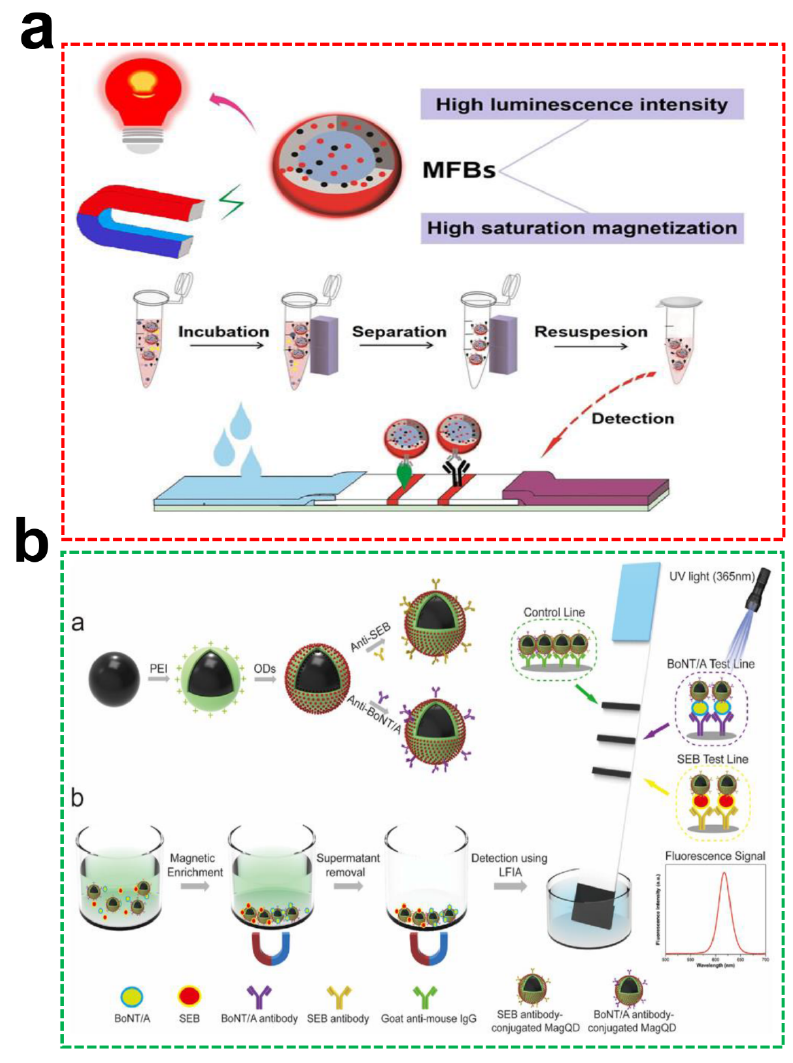
Figure 6. ( a ) Schematic illustration of bifunctional MNPs@QDs-based LFIA for AFB 1 detection in dark soy sauce. Reproduced with permission from [99]. Copyright Analytical Chemistry, 2019; ( b ) The insert ( a ) represent scheme of antibody-modified MNPs@QDs preparation and ( b ) test princi- ples of MNPs@QDs-based two-channel LFIA strip for simultaneous and sensitive detection of two